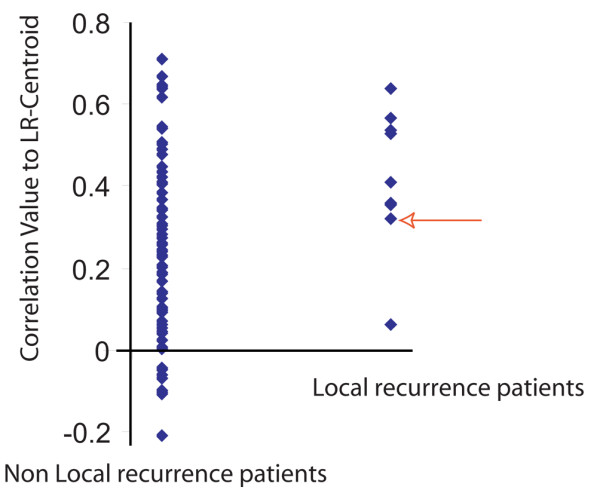
Local recurrence Wound-signature correlation plot for the training set. Red arrow indicates optimal threshold.